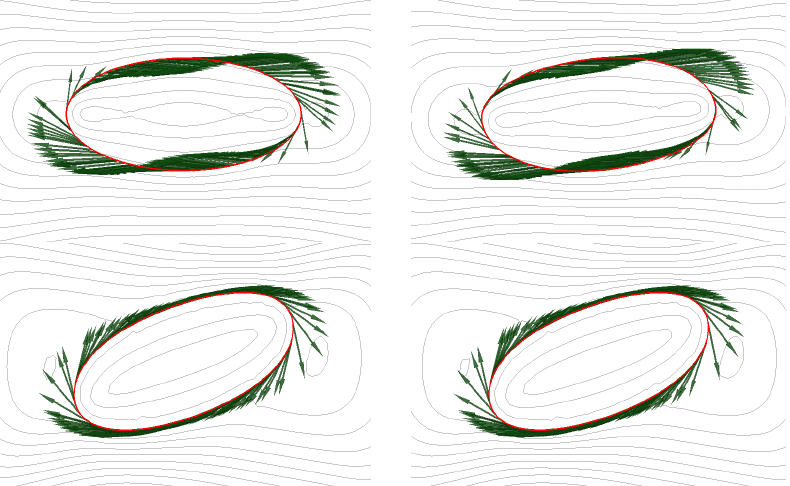
Figure 6. Vesicle with reduced area v = 0.77 following a TT regime in simple shear flow at times t 0.01,0.14,0.52,1.6 . Dimensionless parameters: ¯ µ = 1, Re = 10 − 3 and Bn = 10 3 . The membrane ∈ { } is plotted in red, while the tangential velocity is plotted in green. [Colour figure can be viewed